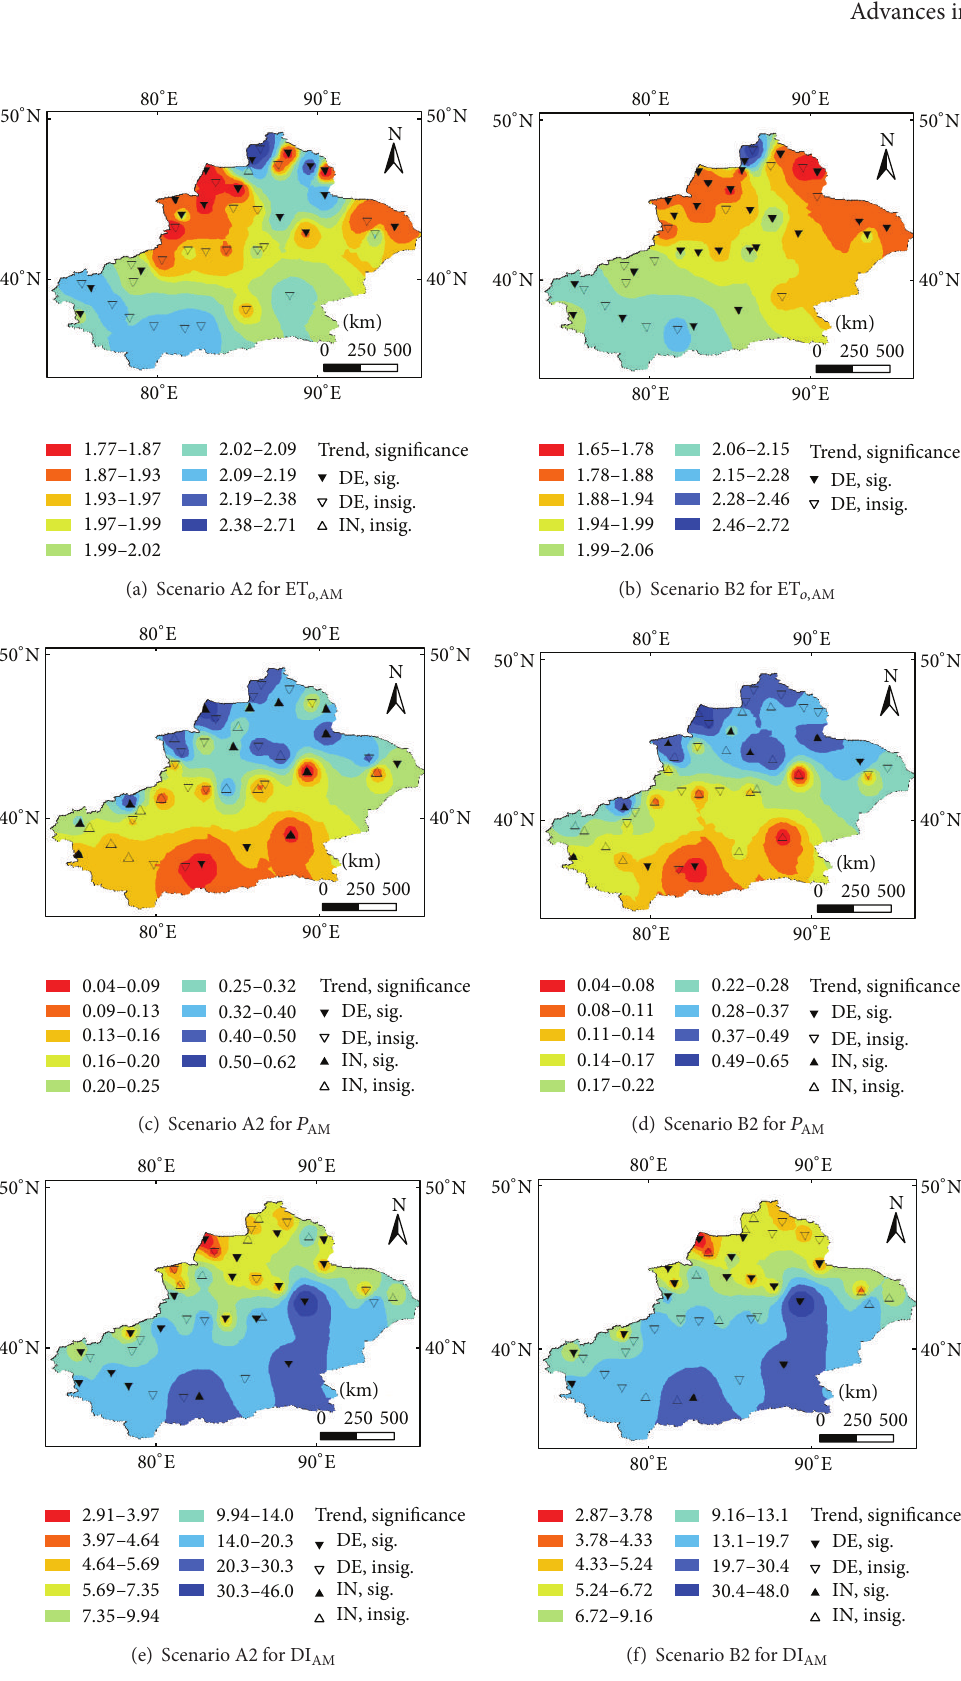
, ET 𝑜, , and DI over AM AM AM